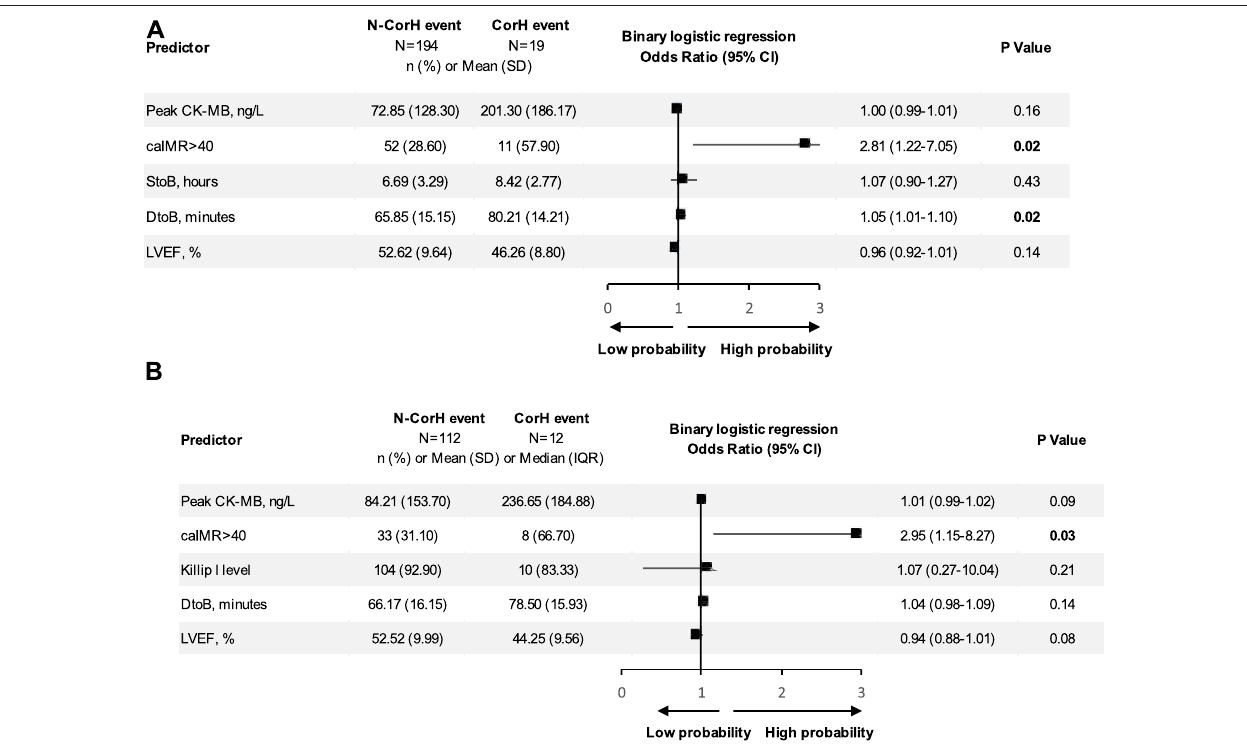
FIGURE6| Binary logisticregressionanalysis.Shownareoddsratios forCorHeventamongpatients. (A) Binarylogisticregressionanalysisofpredictingtheevent group including CV deaths or heart failure readmission (CorH) before propensity score matching. Shown are odds ratios for CorH event among patients before propensity score matching. The size of the square corresponds to the number of patients in two groups. (B) Binary logistic regression analysis of predicting the event group including CV deaths or heart failure readmission (CorH) after propensity score matching. Shown are odds ratios for CorH event among patients after propensity score matching. The size of the square corresponds to the number of patients in two groups. Abbreviations: S to B, time from symptom to balloon; D to B, time from door to balloon; caIMR, coronary-angiography-derived index of microcirculatory resistance; LVEF, Left ventricular ejection fraction; CK-MB, MB isoenzyme of creatine kinase; SD, standard deviation; IQR, inter-quartile range; CI, con fi dence